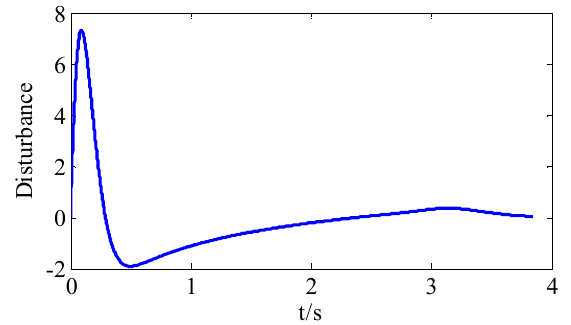
Figure 11. Total disturbance estimated by adaptive RBFNN.